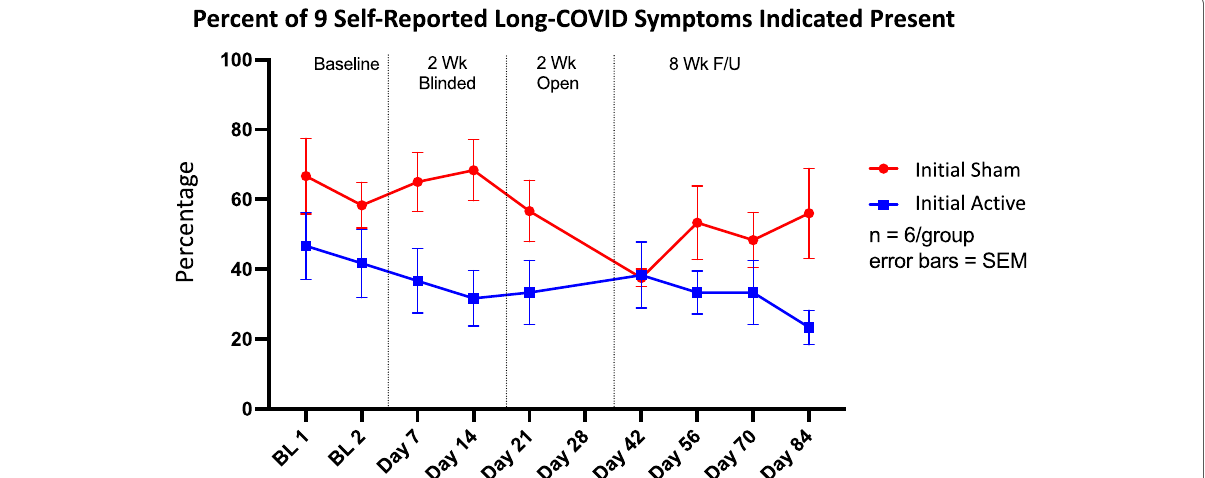
Fig. 5 Long-COVID Symptom Improvement by Randomization Group. In this small sample, taVNS reduced the mean percent of Long-COVID symptoms experienced by participants. During the two-week blinded period, sham taVNS provided no benefit to participants, however during the open label period, those individuals reduced their Long-COVID symptom burden. In the initial active group, we see a marked reduction in Long-COVID symptoms over the course of treatment and